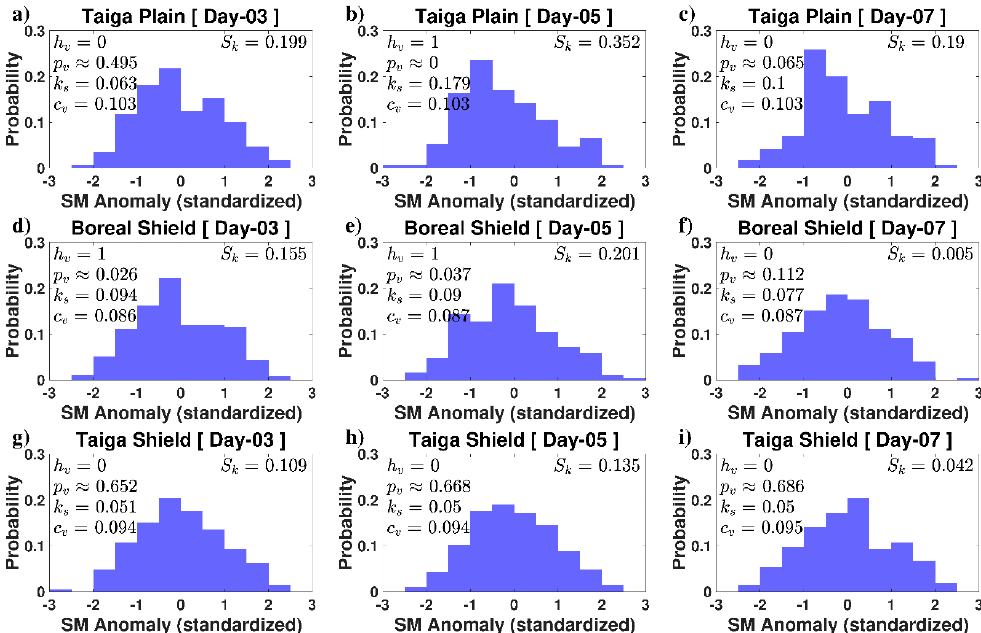
Figure 6. Distributions of fires with burned area greater than 3600 ha, for Taiga Plain ( a – c ), Boreal Shield ( d – f ), and Taiga Shield ( g – i ) ecozones. The parameters h, p, ks, and cv are MATLAB Kolmogorov-Smirnov (KS) test result parameters, as in Figure 4. The parameter Sk (top right) indicates the “skewness” of the distribution.